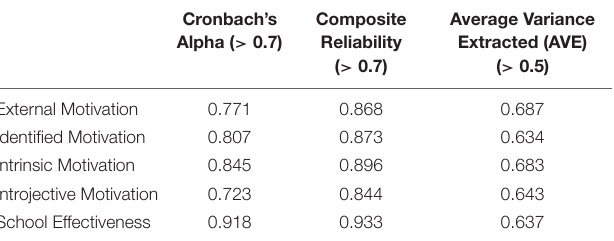
TABLE 4 | Summary of Cronbach’s Alpha analysis and Composite Reliability analysis Cronbach’s Alpha.